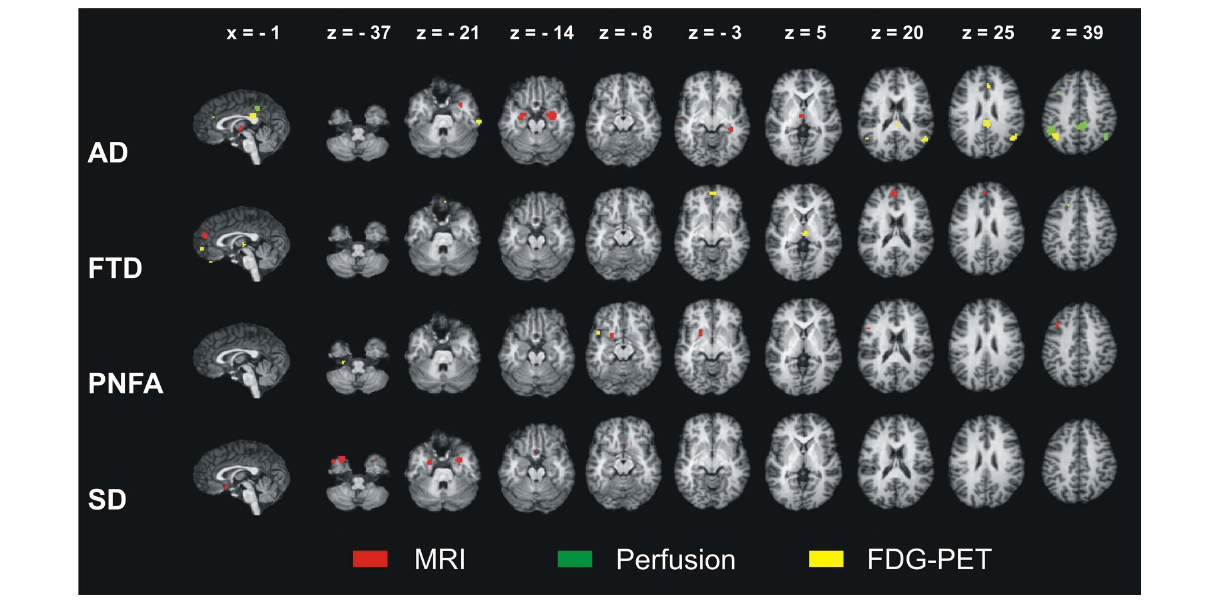
FIGuRE 1 | Results of the ALE meta-analyses identifying the neural correlates of Alzheimer’s disease (AD), frontotemporal dementia (FTD), progressive non-fluent aphasia (PNFA), and semantic dementia (SD). Atrophy as measured by magnetic resonance imaging (MRI) and decreases in glucose